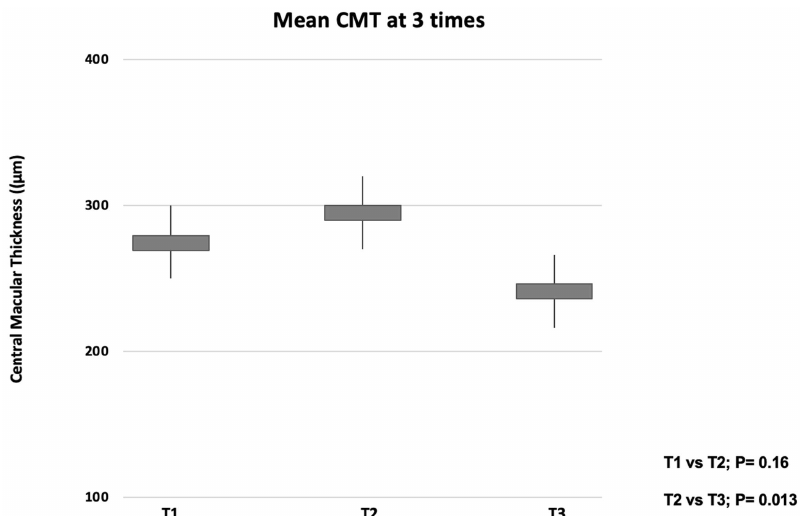
Figure 3. Box and whisker plots showing analyzed central macular thickness (CMT) measurements at each time. The ends of the whiskers represent the minimum and maximum values.